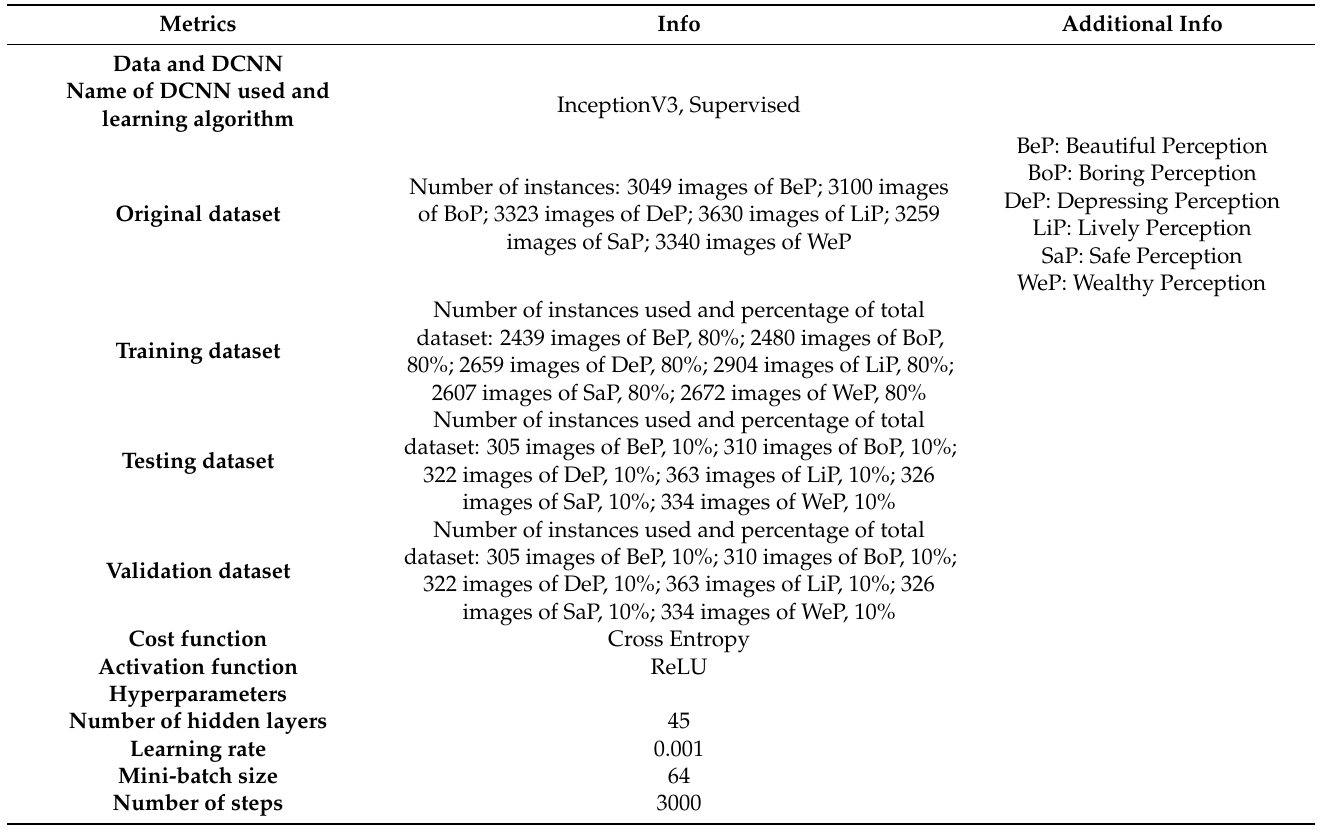
Table 2. Reporting the DCNN of this study used.